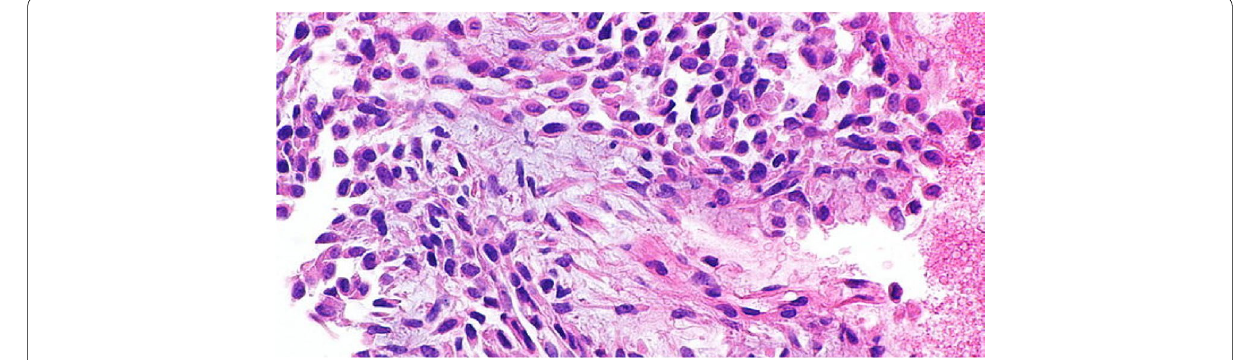
Fig. 5 Histopathology image of pleomorphic